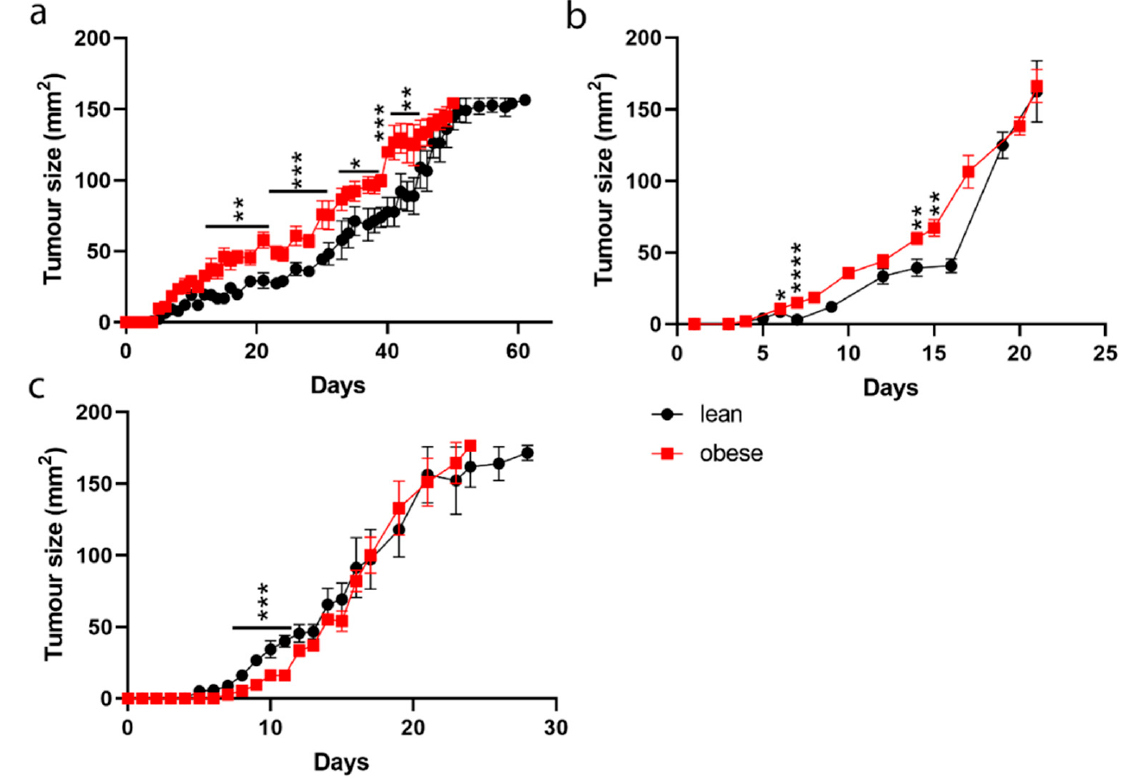
Figure 3. Tumour growth rate in lean and obese mice. ( a ) C57mg BC cells and ( b ) EO771.LMB metastatic BC cells were injected percutaneously into the mammary fat pads of lean and obese mice and tumour growth rate was recorded; ( c ) MC38 CRC cells were injected subcutaneously into the right flank of lean and obese mice and tumour growth rate was recorded. Results are the mean ± STD of n = 5 mice/group. Statistical significance was determined using a Wilcoxon rank-sum test. * p < 0.05, ** p < 0.01, *** p < 0.001, **** p < 0.0001.